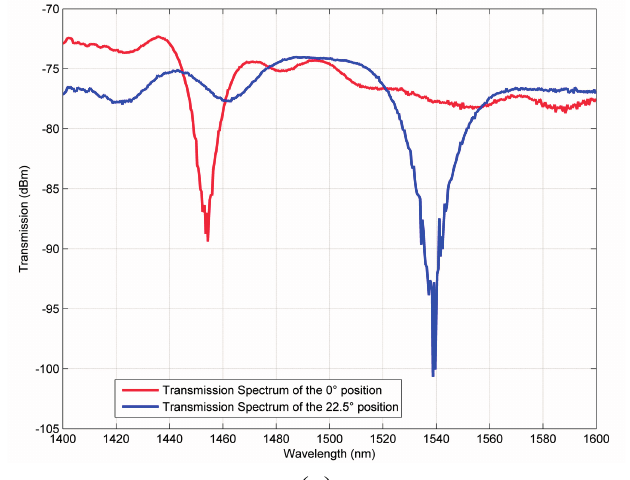
Figure 1. Sensor behavior: ( a ) the response to mechanical action; ( b ) linearity without filter; ( c ) linearity with